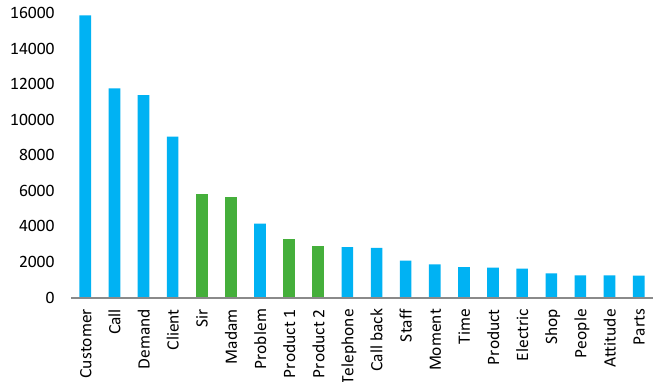
Figure 6. Statistical results of noun frequency in the natural texts of complaint contents.